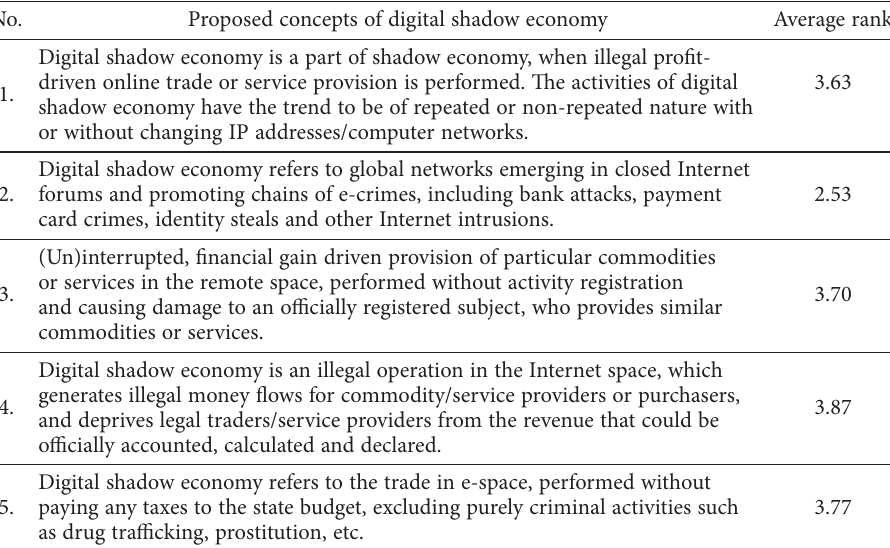
Table 4. Average ranks for acceptability of different concepts of digital shadow